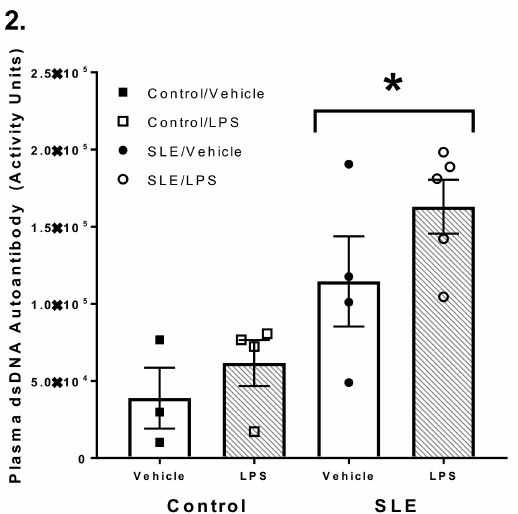
Figure 2. Systemic lupus erythematosus (SLE) mice have elevated plasma anti-dsDNA autoantibodies compared to NZW and C57 control mice, regardless of treatment group. All values are reported as mean ± SEM, and the results of the two-way ANOVA indicated a significant difference between control and SLE mice. * p SLE/Vehicle and SLE/ lipopolysaccharide (LPS) vs. Control/Vehicle. 3.2. LPS Challenge Elicits Similar Parvocellular Paraventricular Nuclei Activation between SLE and Control Mice Following intraperitoneal injection of vehicle, paraventricular c-Fos expression did not differ between SLE and C57 mice (17.0 ± 3.2 vs. 14.2 ± 2.9 cells/field; data not shown; p = 0.537). Similarly, there were no differences in c-Fos expression between SLE and control ( NZW ) mice (17.0 ± 3.2 vs. 18.2 ± 1.9 cells/field, p = 0.867). LPS increased c-Fos neuronal expression in both SLE and control mice compared their vehicle-treated counterparts (39.2 ± 5.5 vs. 17.0 ± 3.2 cells/field, p = 0.007 for SLE; 42.3 ± 7.8 vs. 18.2 ± 1.9 cells/field, p = 0.004 for controls) (Figure 3C), and by the same magnitude (39.2 ± 5.5 vs. 42.3 ± 7.8 cells/field, p = 0.672).